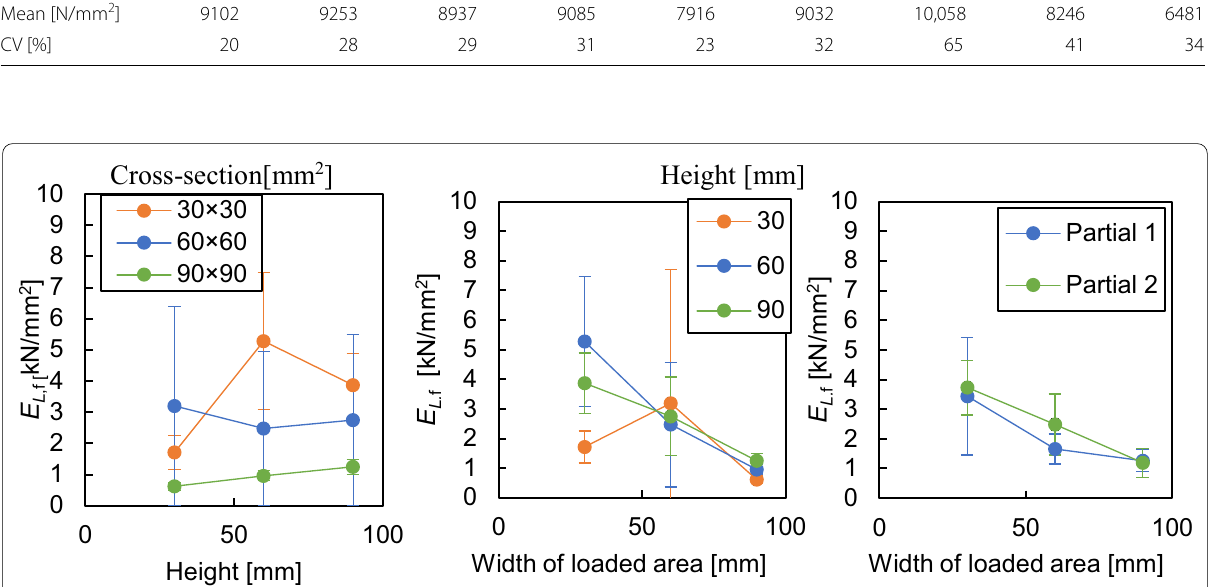
Fig. 12 Influence of heights and widths of the loaded area on values of E L, f of the entire and partial surface-loaded